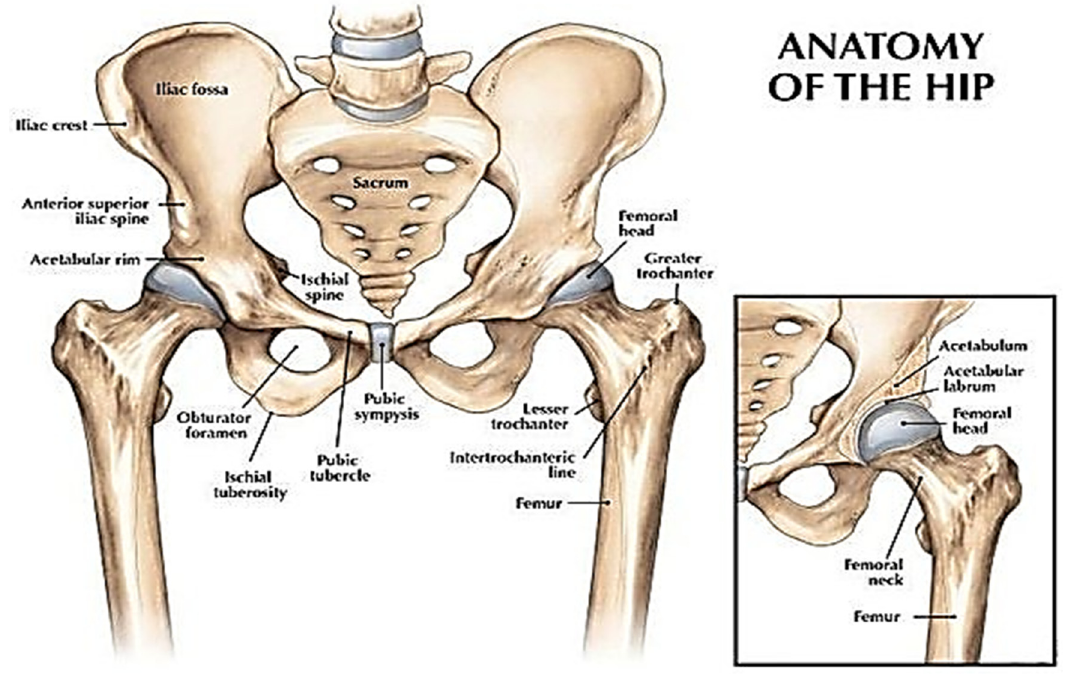
Figure 1. A view of the hip joint [2]. Reprinted with permission from Ref. [2]. Copyright 2007, Lippincott Williams & Wilkins, Inc.